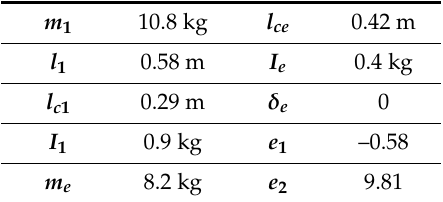
Table 2. Structure parameters of picking robot.